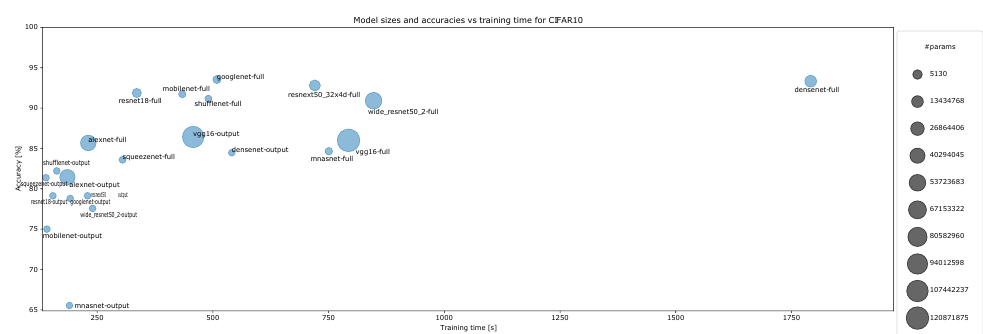
Figure A18. Accuracy vs, training time and model size for CIFAR-10 for one-episode